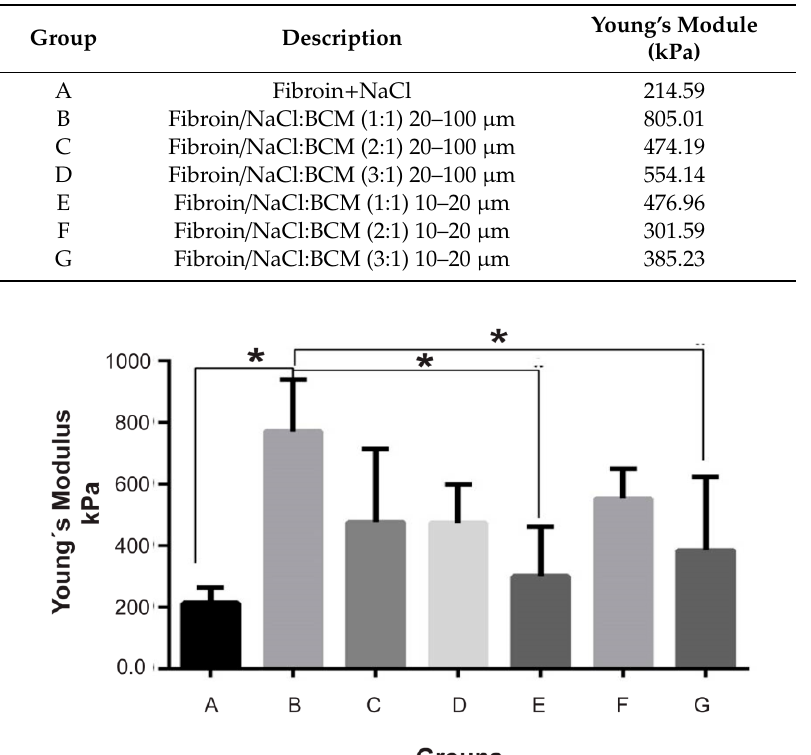
Table 1. This is a table showing Young’s modulus via an unconfined compression assay.